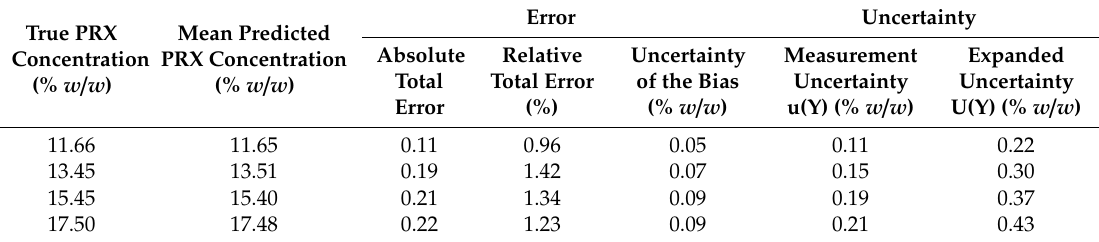
Table 5. Error and uncertainty results for each concentration level in the validation data